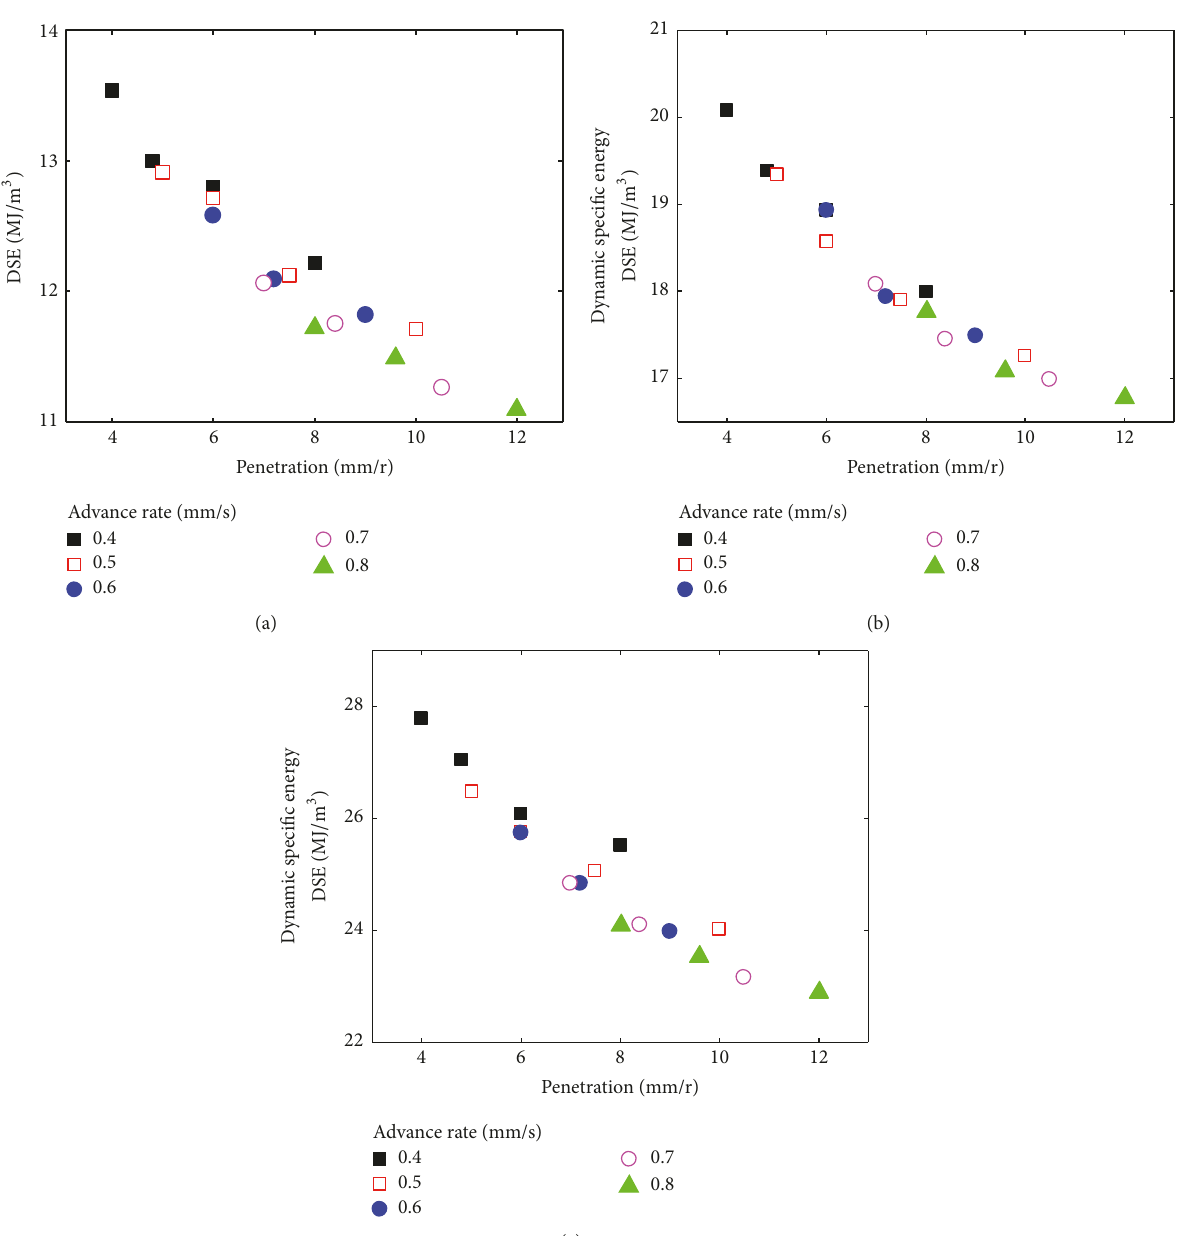
Figure 5: Correlation of dynamic specific energy (DSE) and operational parameters for (a) soft rock, (b) moderately hard rock, and (c) hard